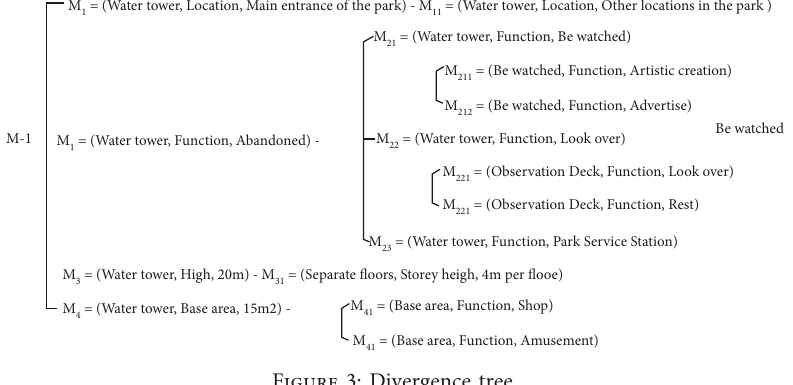
Figure 3: Divergence